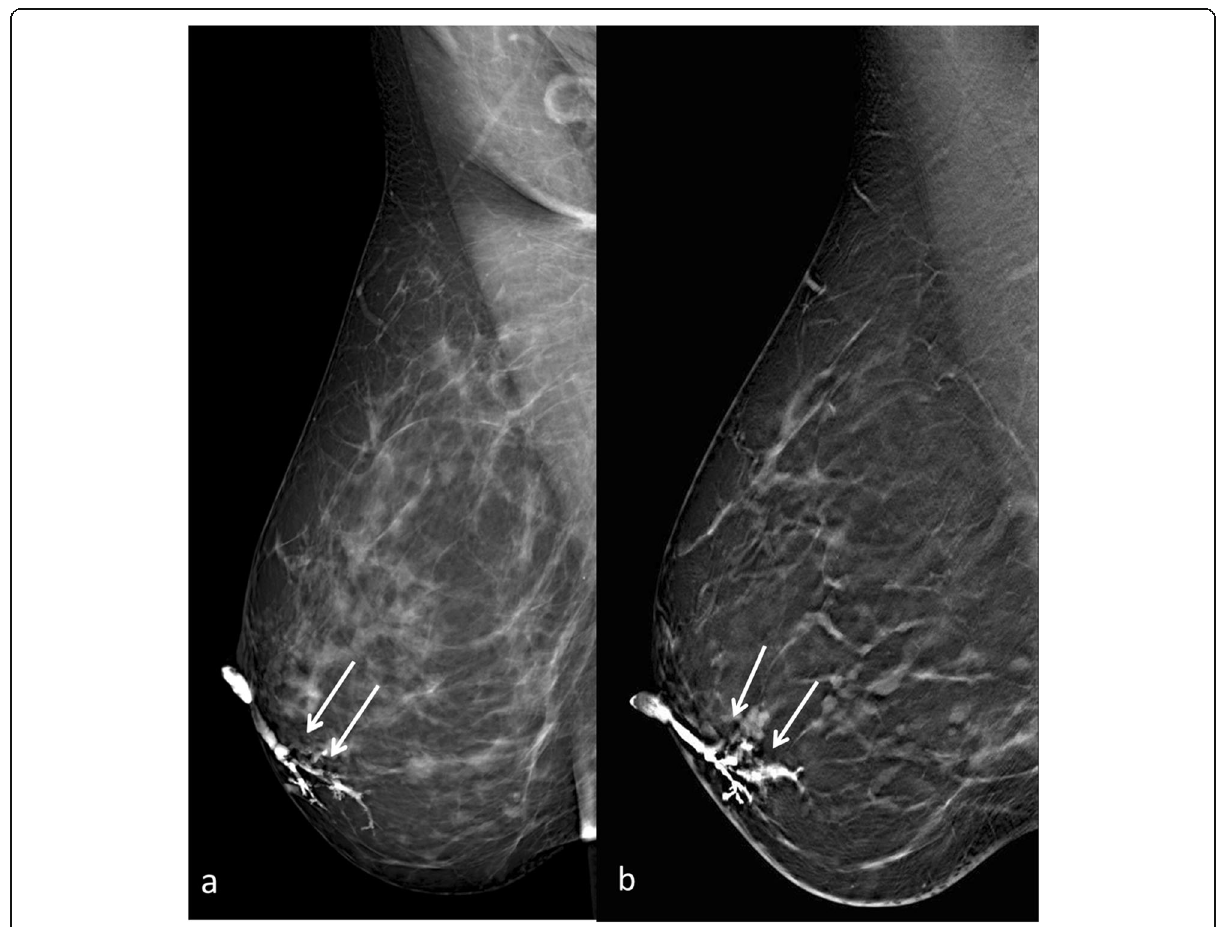
Fig. 2 a Full-field digital (FFD)-galactography. b Digital breast tomosynthesis (DBT)-galactography. Papillomatosis of the right breast in a 42-year- old patient. The intraductal multiple filling defects are identified on both conventional and DBT-galactography (arrows)